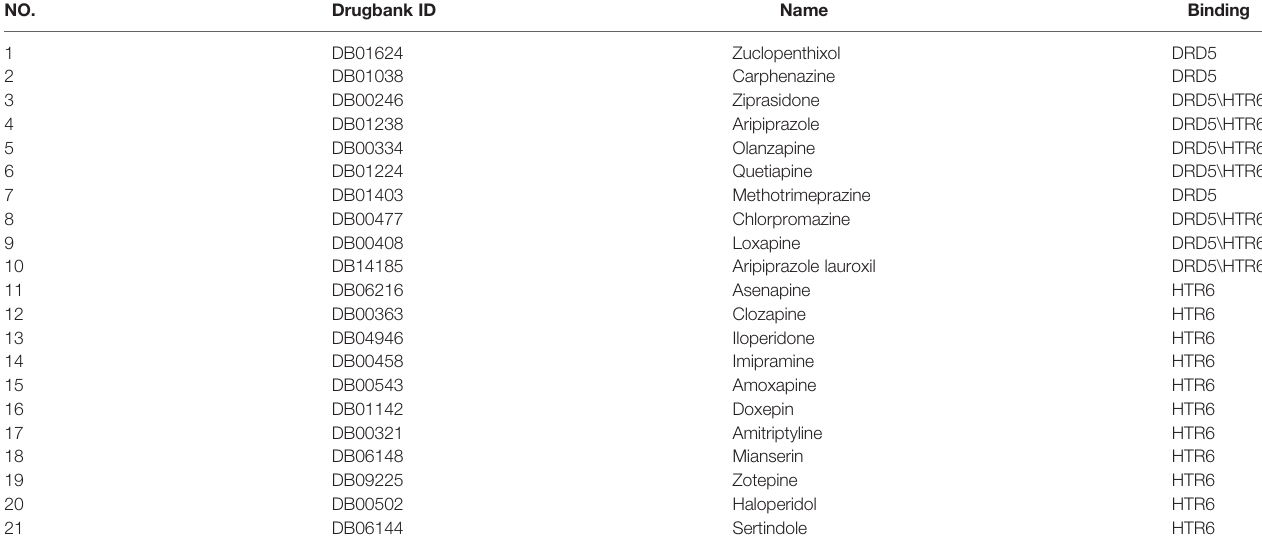
TABLE 3 | The antipsychotic drugs targeting DRD5 or HTR6.